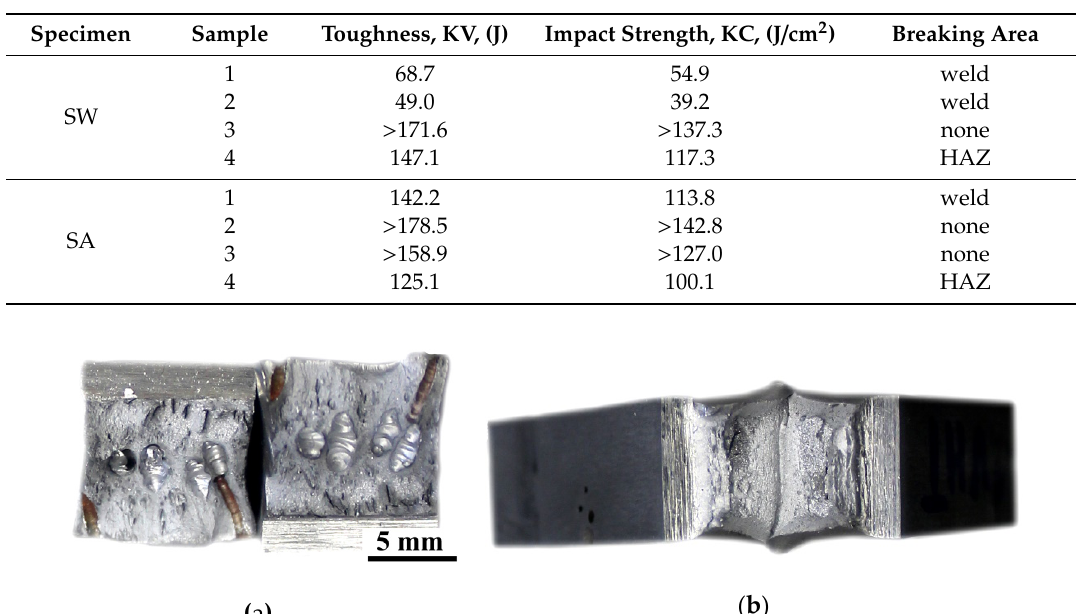
Table 6. Results of the Charpy impact test.